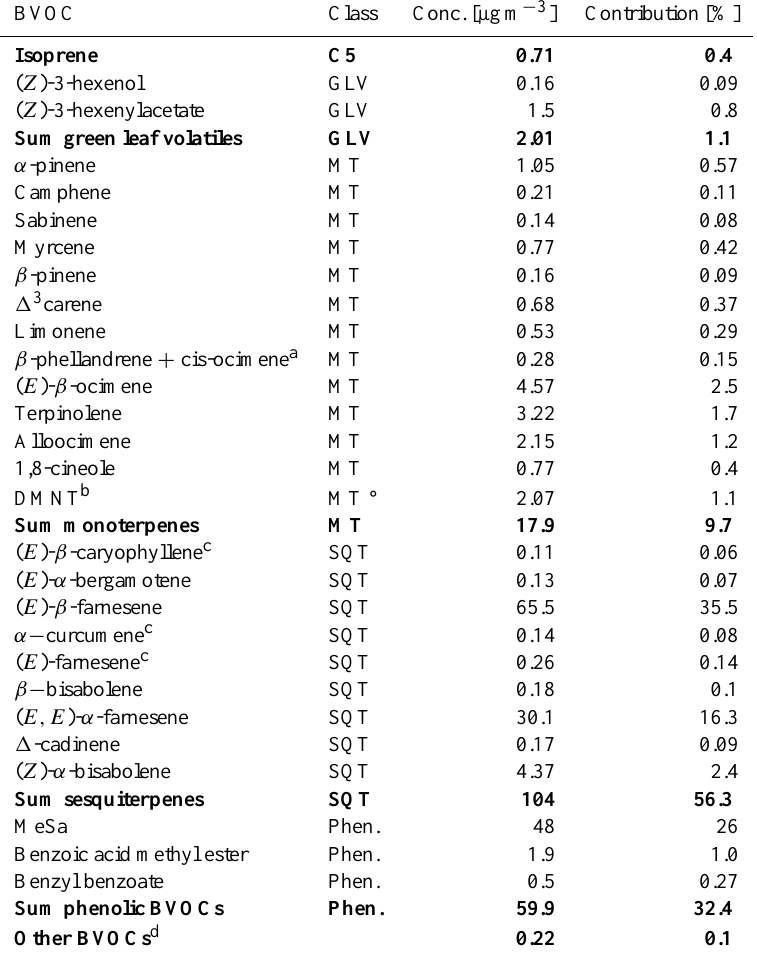
Table 3. Major BVOCs emitted from the set of plants used in Experiment #1 (data is for day 5 in Fig. 1). BVOCs with concentrations above 0.1µgm − 3 are listed explicitly. Concentrations listed for the sum of BVOC classes (bold) include also BVOCs with concentrations below 0.1µgm − 3